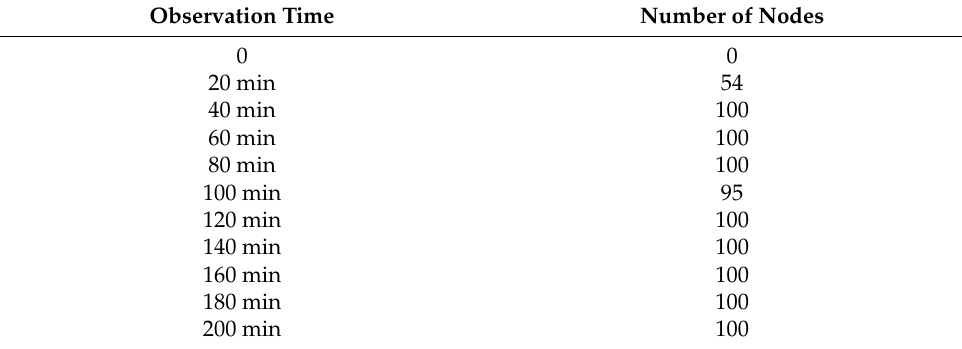
Table 4. Number of